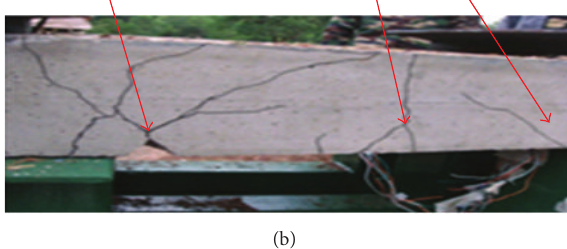
Figure 11: (a) Simulation results for NRC panel. (b) Experiment results for NRC